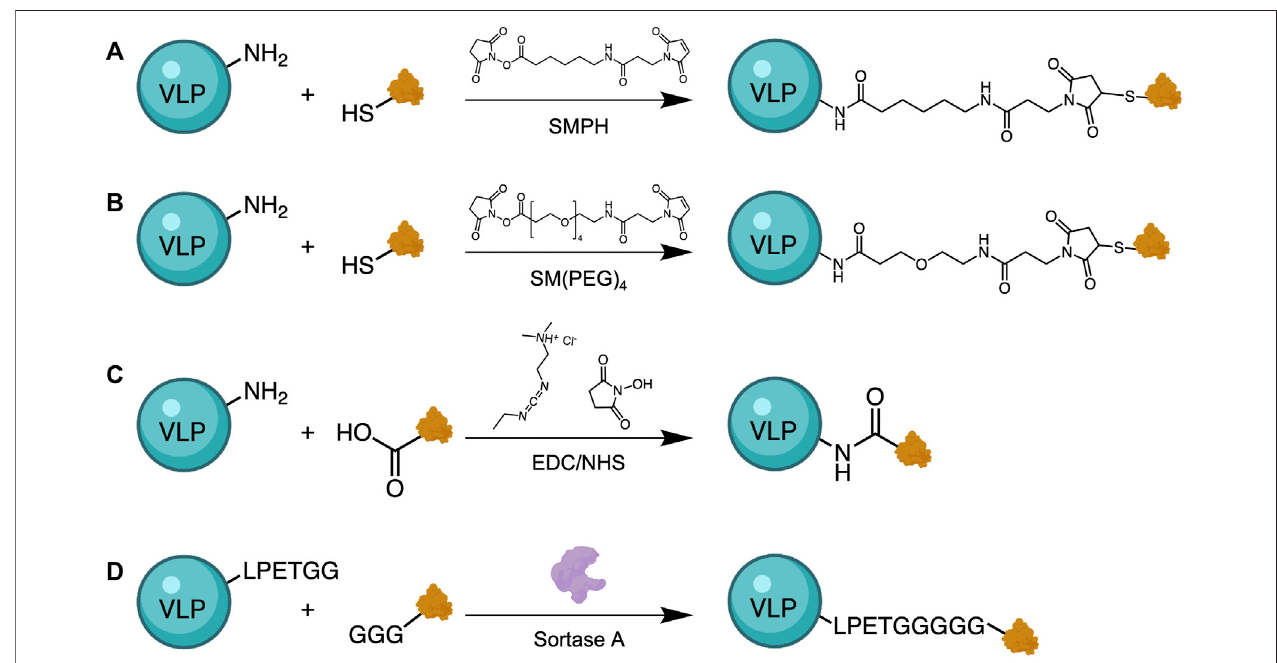
FIGURE5| ApproachesforantigenconjugationtoVLPs.Heterobifunctionalcrosslinkers, suchasSMPH (A) orSM(PEG) 4 (B) ,havebeenusedtolinkVLPswithan antigen of interest. These linkers react with free primary amines from lysine residues on VLPs and thiols from genetically inserted cysteine residues on the antigen. Alternative methods use carbodiimide chemistry to activate the less reactive carboxylic acid residues on the antigen for reaction with amines on the VLPs (C) , and Sortase-mediated transpeptidation (D) . Sortase A catalyzes the binding of a target sequence (GGG), often bound to antigen, with an LPETGG tag genetically added to the VLP